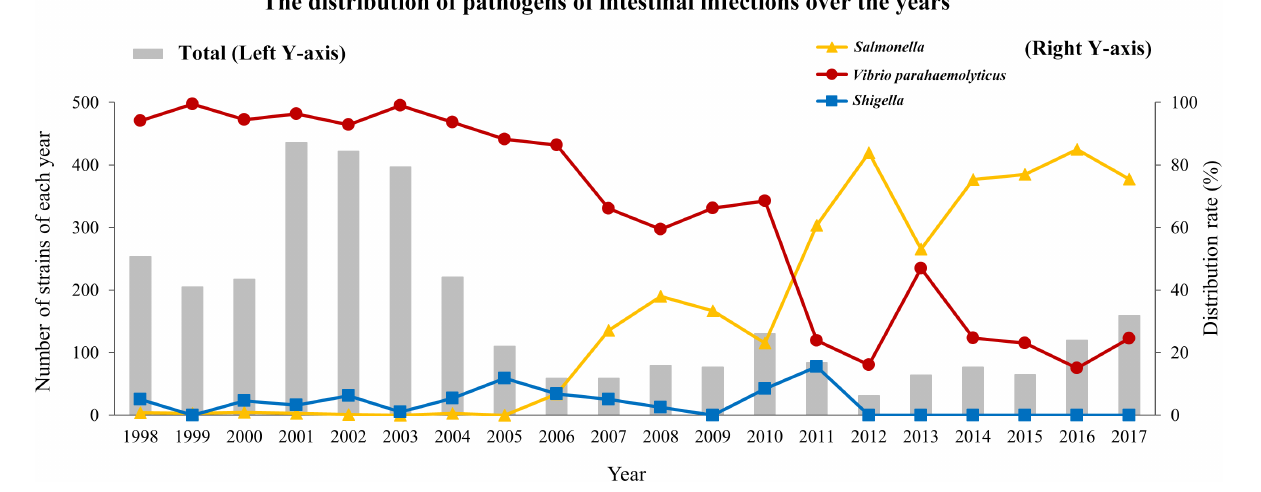
FIGURE 1 | Distribution of Salmonella , Vibrio parahaemolyticus and Shigella caused intestinal infections between 1998 and 2017.